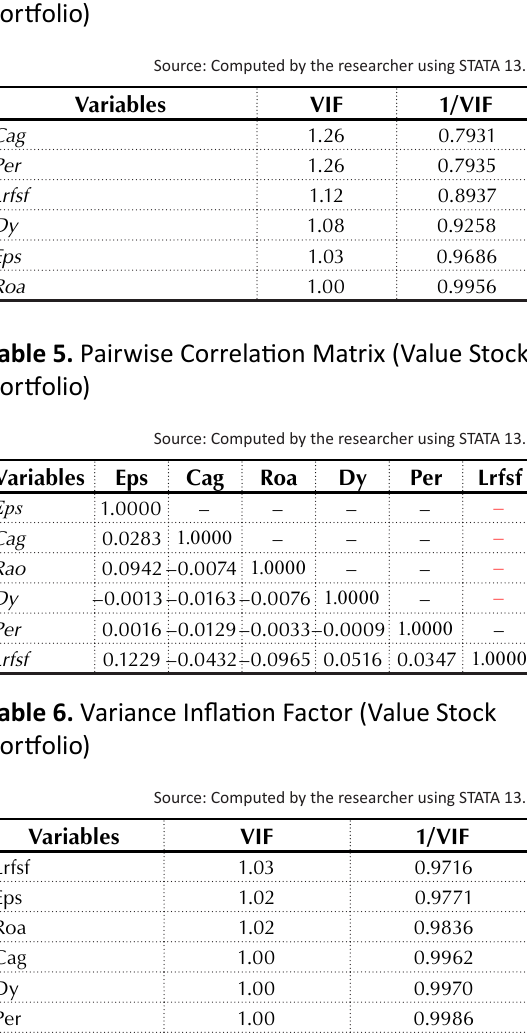
Table 4. Variance Inflation Factor (Growth Stock Portfolio)